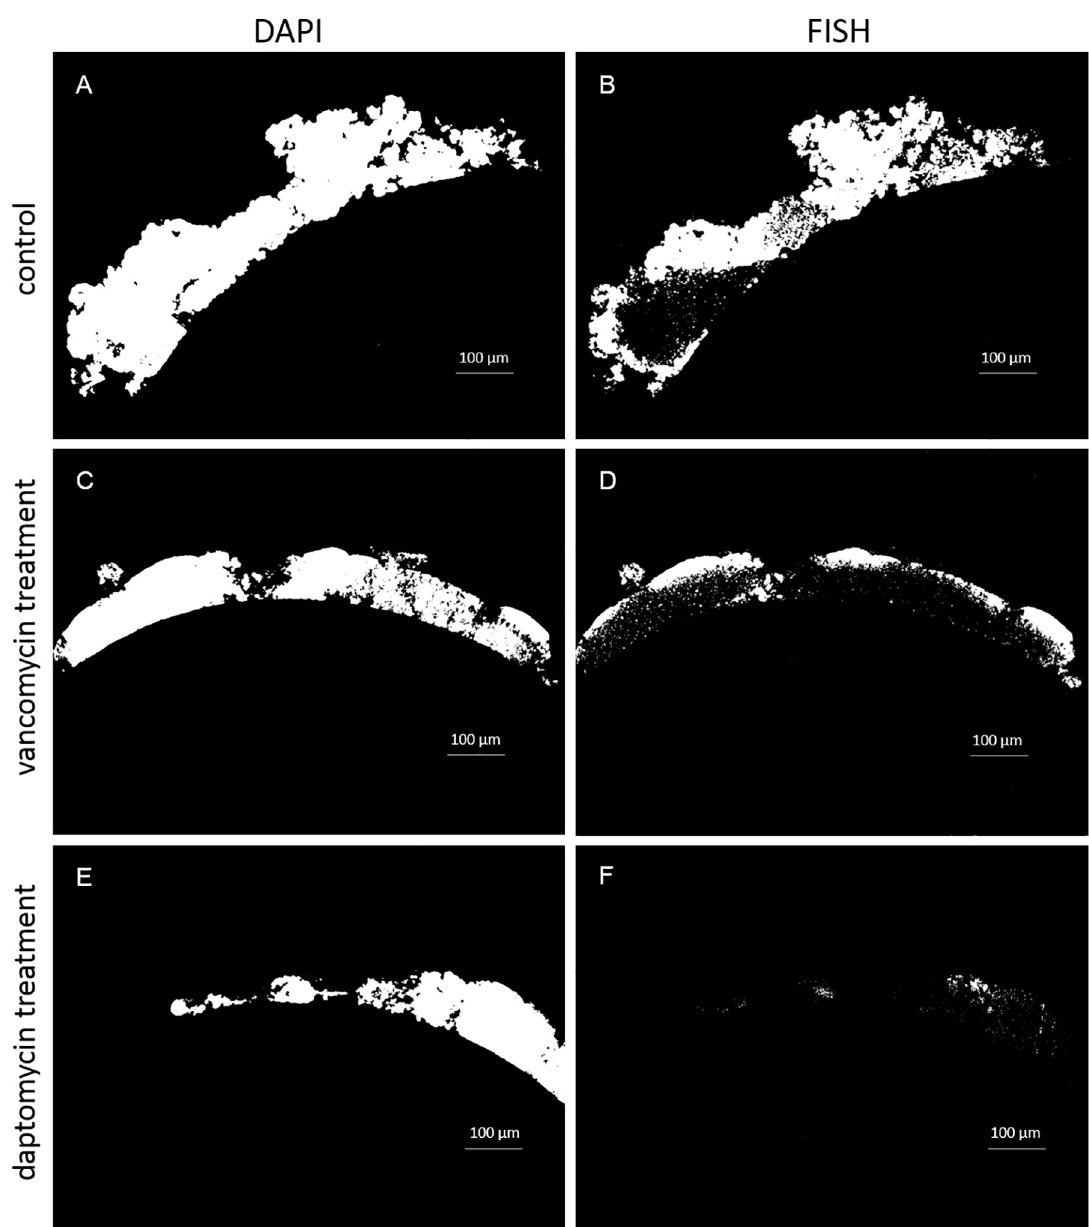
Fig 1. Digital image analysis using daime shows the reduction of total biofilm area and FISH-positive fraction, respectively, for in vitro S . epidermidis . A and B show DAPI and FISH masks, respectively, of the control biofilm treated with PBS. C and D show DAPI and FISH masks for biofilm on a catheter treated with vancomycin, and E and F show DAPI and FISH masks for biofilm on a catheter treated with daptomycin, respectively. The reduction of FISH positive areas after treatment with vancomycin (D) and even more with daptomycin (F) is clearly visible.